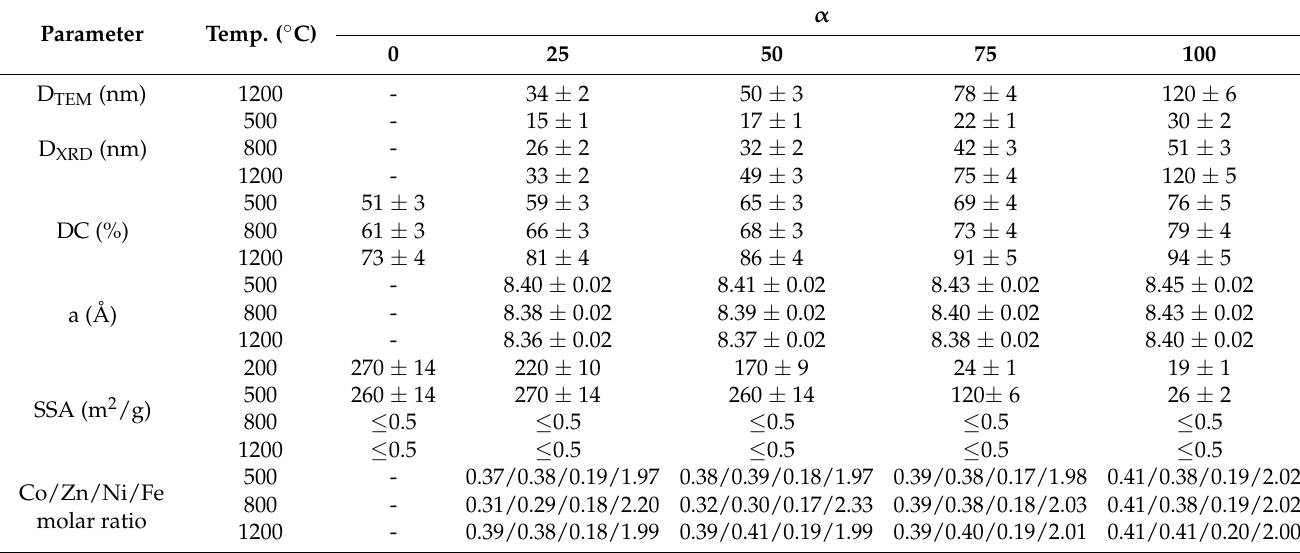
Table 1. Particle size (D TEM ), crystallites size (D XRD ), crystallinity degree (DC), lattice constant (a), hopping length (L A and L B ), specific surface area (SSA), and Co/Zn/Ni/Fe molar ratio